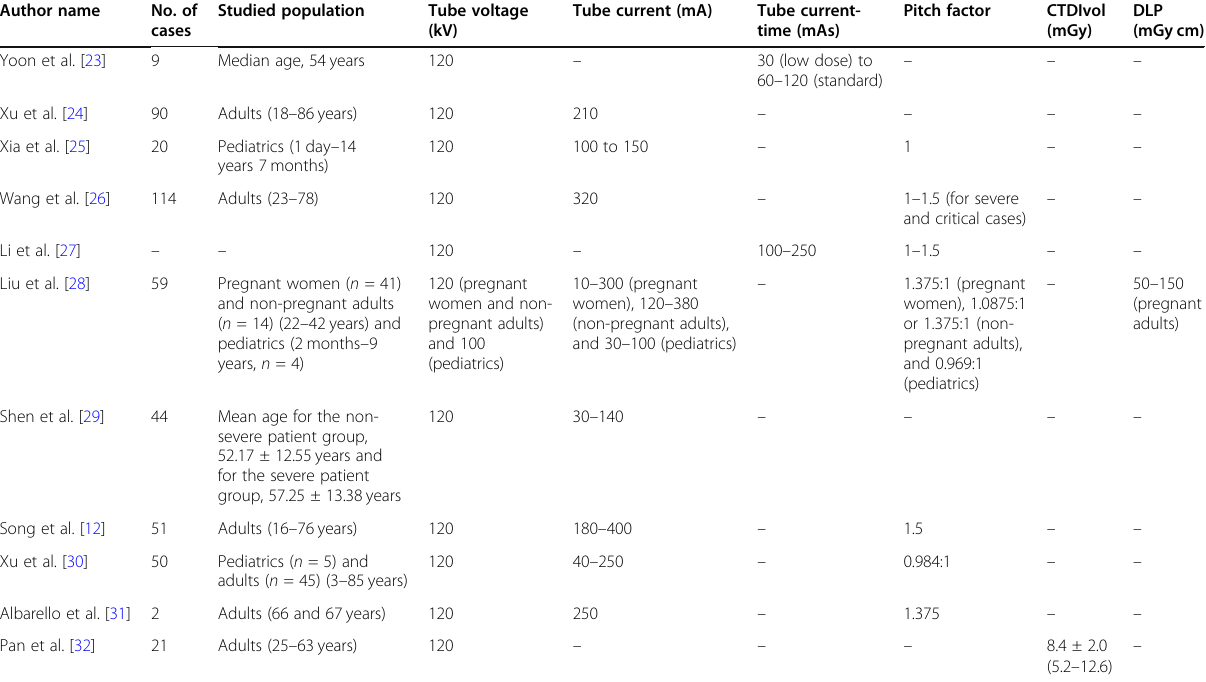
Table 1 The data extracted from a number of studies conducted on patients infected with COVID-19: focusing on chest CT scanning